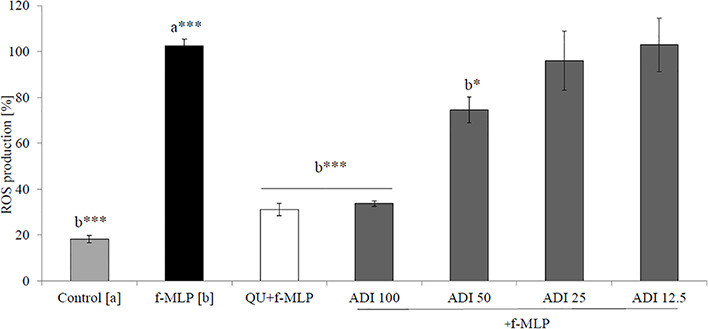
Effect of the ADI at concentrations of 12.5-100 µg/mL on ROS production by f-MLP-stimulated neutrophils [%], mean ± SEM. Positive control quercetin (QU) at a concentration of 20 µM. Statistical significance of differences was established by ANOVA with post hoc test, *p < 0.05 ***p < 0.001, a*** - statistical significance of differences between f-MLP stimulated control compared control, b - compared to the to the stimulated control f-MLP.